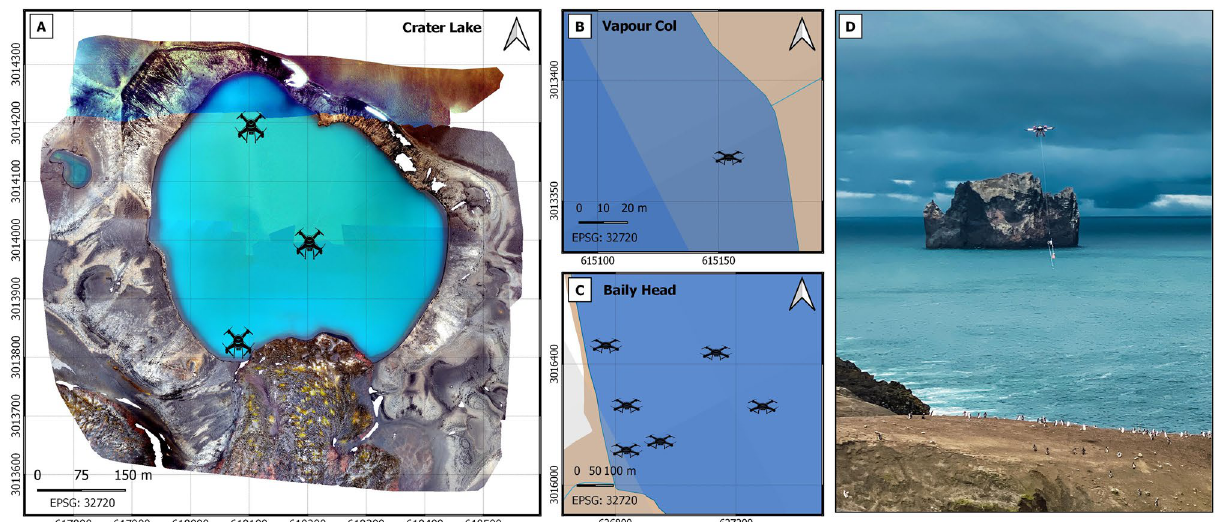
Figure 4. Locations of surface water samples collected in Crater lake ( A ), Vapour Col ( B ), and Baily Head ( C ) using aerial water sampling device, and picture of the UAV (hexacopter) carrying, at 100 m altitude, the water sampling device and the multiparametric instrument ( D ). Stations at Crater lake are plotted on a mosaic composed of 3096 pictures taken during three flights of 14 min each at 120 m altitude using a quadcopter with an integrated RGB camera and a multispectral camera array with 5 bands, achieving 6.5 cm/pixel